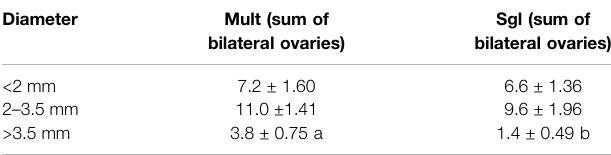
TABLE 1 | Statistical results of the number of bilateral ovarian